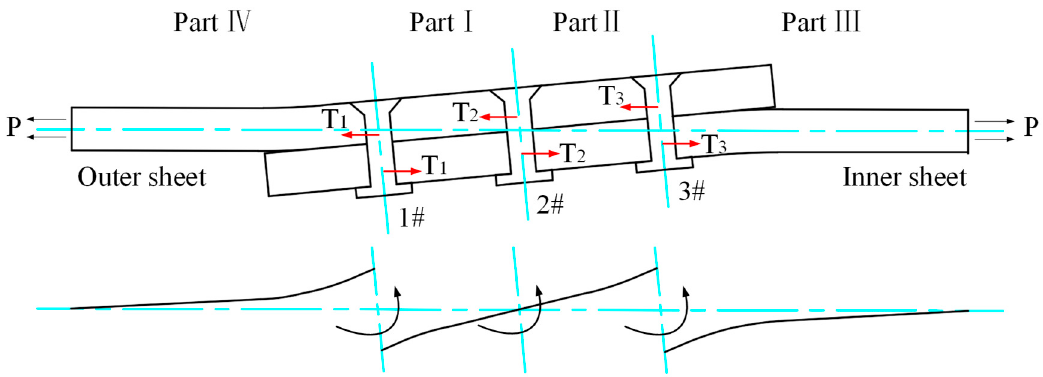
Figure 2. Regional deformation of the riveted lap joint.